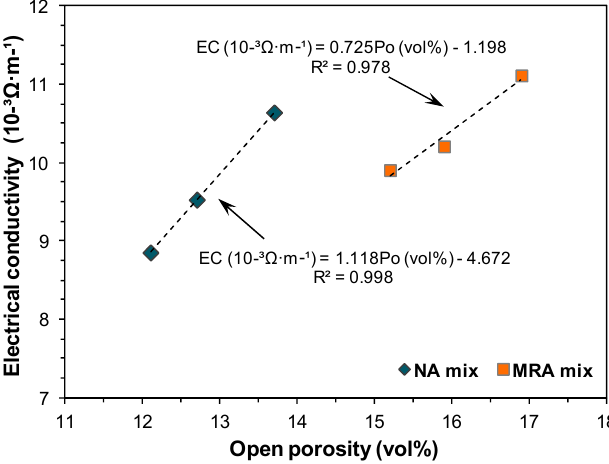
Figure 4. ( a ) Open porosity − ( b ) dry density; and ( c ) electrical conductivity as a function of the GRC replacement ratio.